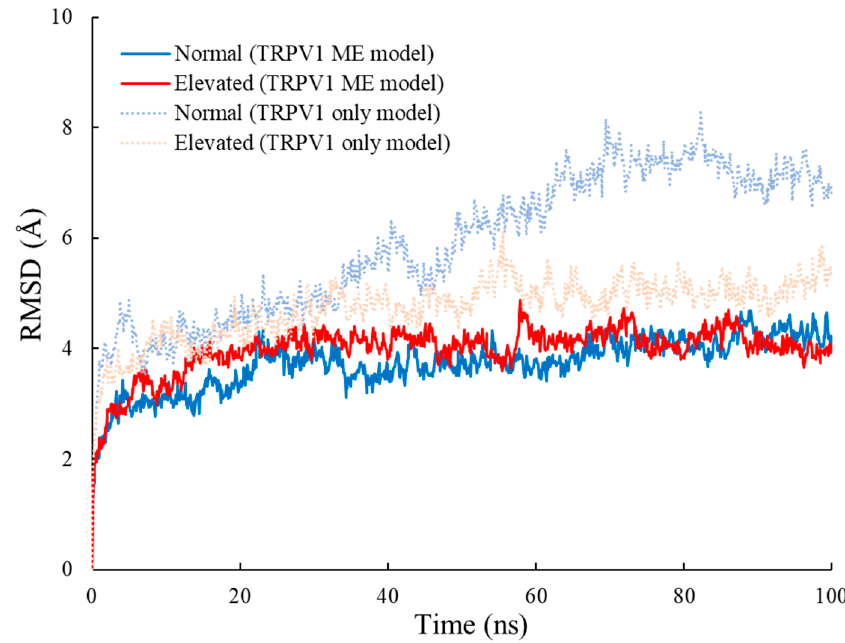
Figure 2. Root mean squared deviation (RMSD) of TRPV1. Molecular dynamics (MD) simulated at normal (12.6 mmHg) and elevated (27.6 mmHg) hydrostatic pressure are shown in blue and red, respectively, using TRPV1-only and TRPV1 membrane-embedded (ME) models. Data are plotted using all 10,000 timeframes obtained from the output trajectory files.